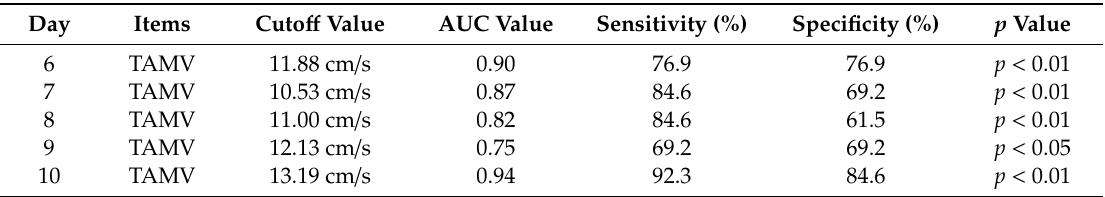
Table 2. Summary of the ROC analyses of the time average medium velocity (TAMV) from Day 6 to Day 10 post TAI in bu ff aloes during the transitional